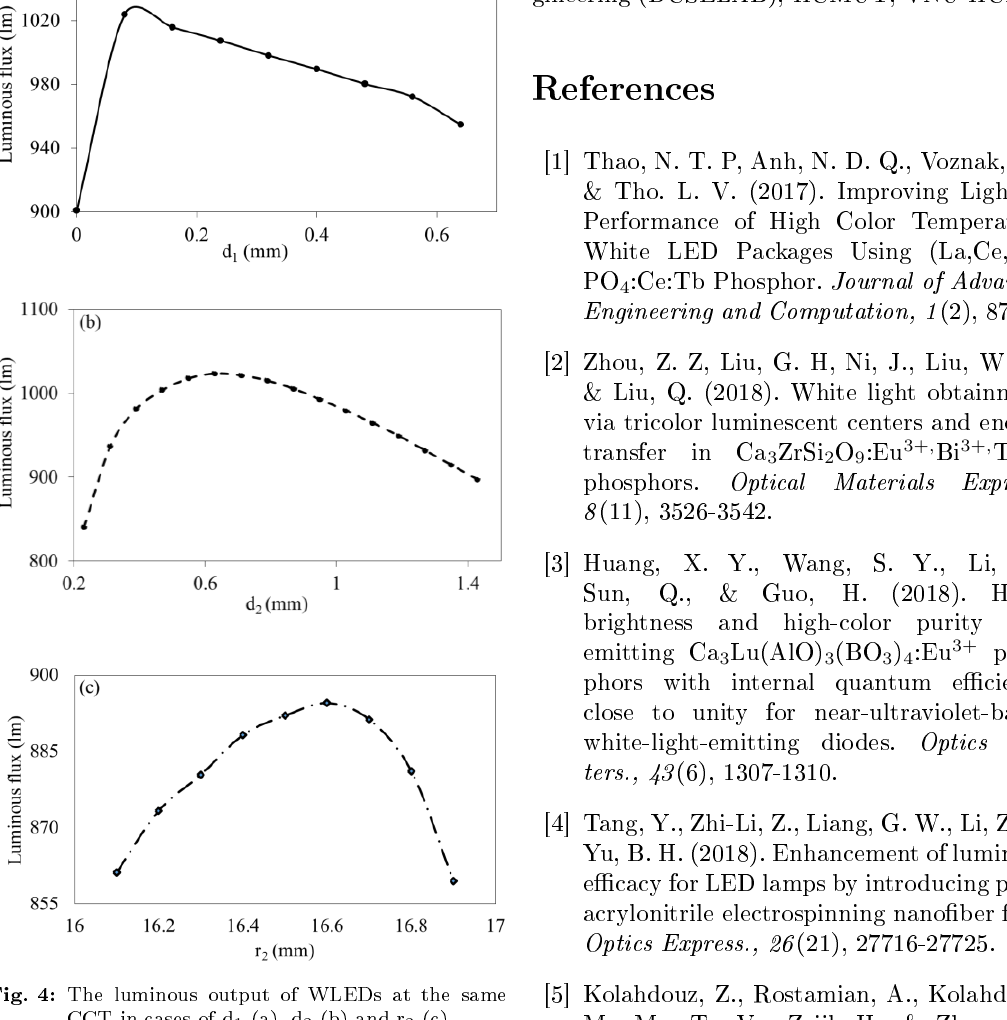
Fig. 4: The luminous output of WLEDs at the same Figure 4 : The luminous output of WLEDs at the same CCT in cases of d 1 (a), d 2 (b) and r 2 CCT in cases of d (a), d (b) and r (c) 1 2 2 For the CDRP structure, the concave surface favorably backscatters light on the surface of the LED chip, so there is more misplaced radiated light energy. This clarifies for